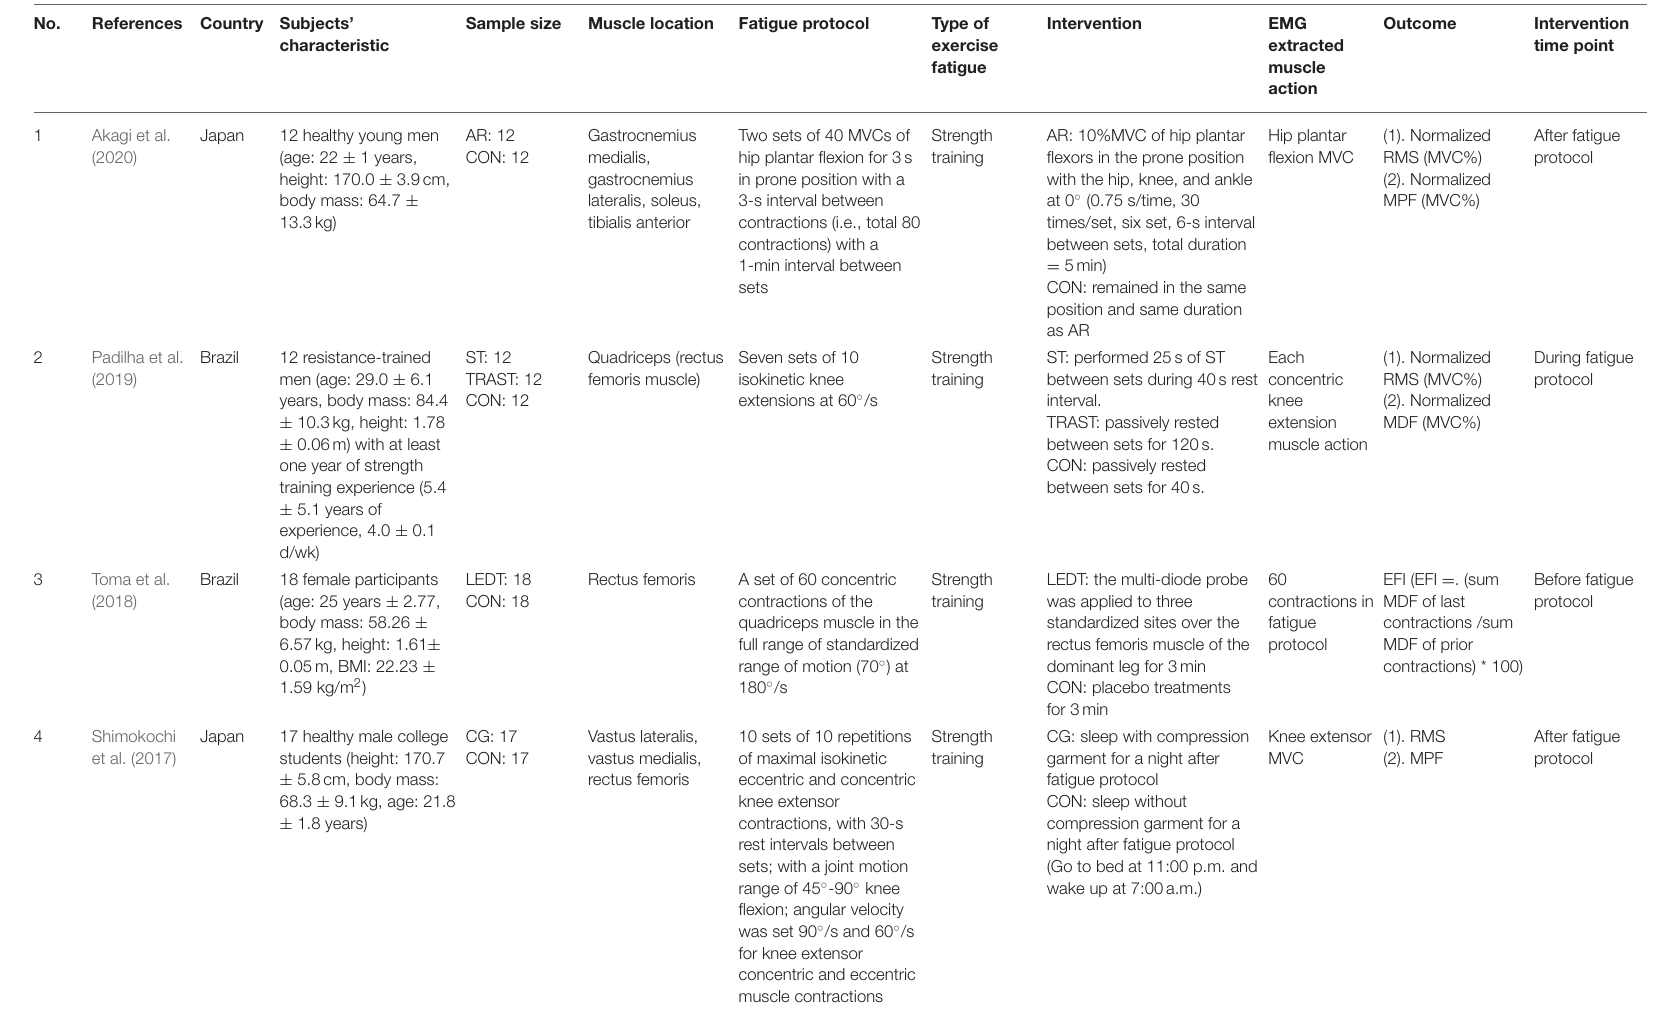
TABLE 1 | The characteristic of included articles.